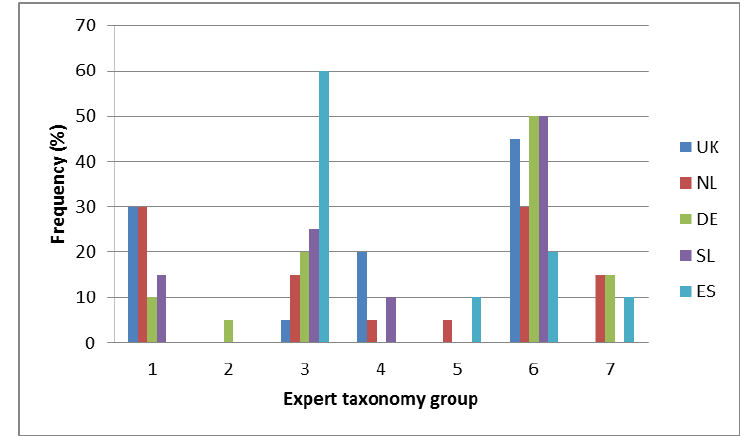
Figure A5. Frequency of structured sort placement of nutrition claims per country—‘Source of omega-3’ (Card 24). Nutrients 2018 , 10 , x FOR PEER REVIEW